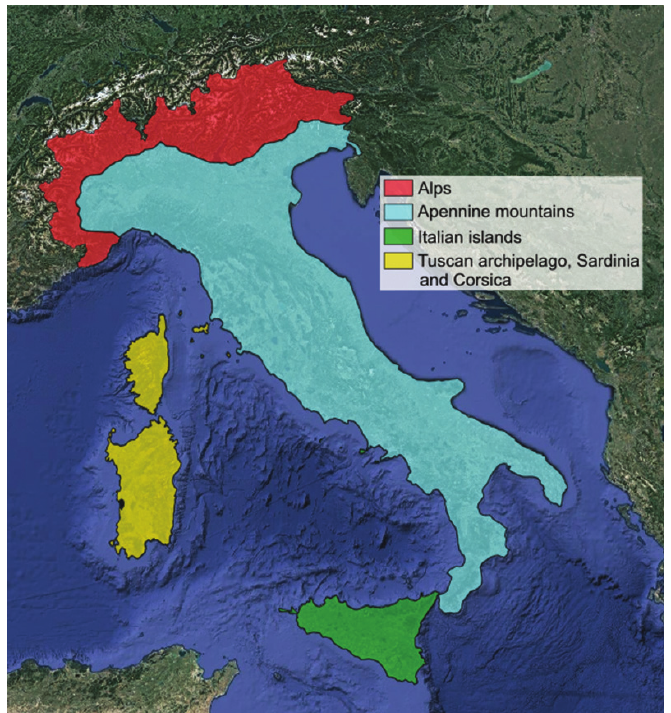
Figure 1. Map of the four regions in which the study area is